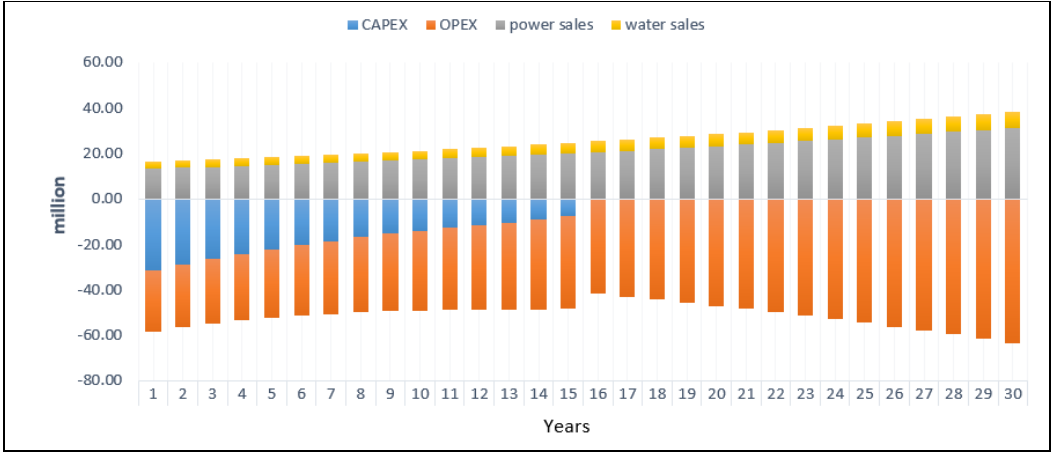
Figure 9. Expenditure and income distribution over 30 years.